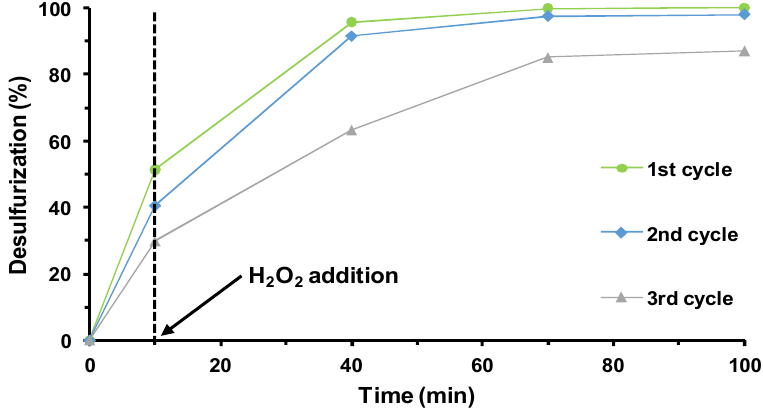
Figure 5. Kinetic desulfurization profiles catalyzed by [BPy] 3 PW 12 for three consecutive ECODS cycles using ionic liquid ([BMIM]PF 6 ) as extraction solvent at 70 °C.